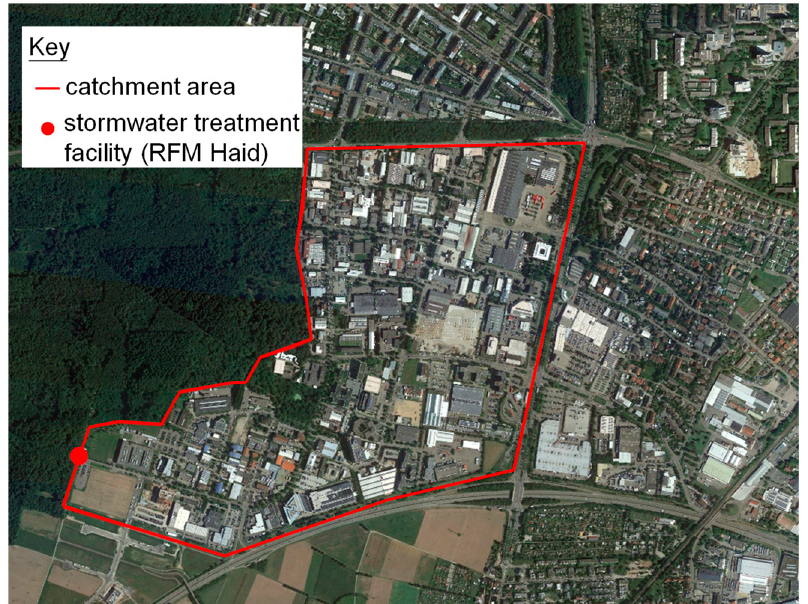
Figure 1. Catchment area of the monitored stormwater treatment facility. Industrial park “Freiburg Haid”.